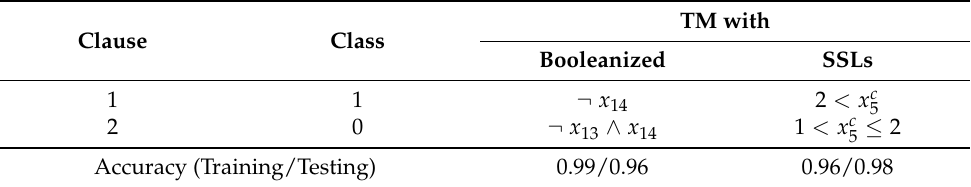
Table 7. Clauses produced by TM with Booleanization and SSL schemes for m =